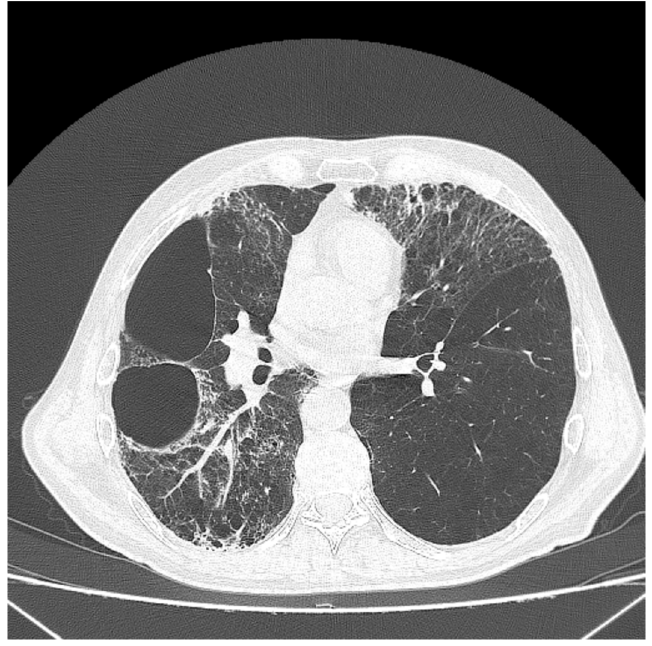
Figure 2. CT evaluation—2020—during acute viral infection indicated bilateral pneumonia, with ‘honeycomb’ lesions, which were confluent in the two big bullae on the right. Suddenly, the patient complained of severe dyspnea during rest and right thoracic pain, with hypotension, tachycardia, and pallid face. The arterial blood gas test indicated severe hypoxia but the hemoglobin level also decreased (loss of 5 points). We performed a standard chest radiography, where a right basal pneumothorax with opacification of what could be bullous lesions was observed, as shown in Figure 3.